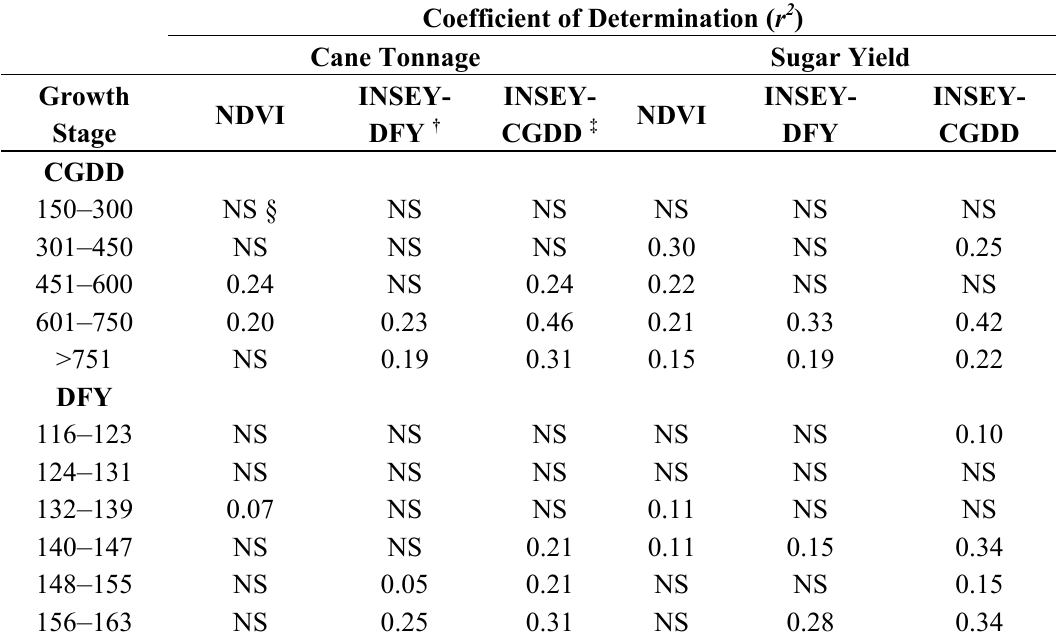
Table 6. Exponential relationship between spectral reflectance measurements and sugarcane crop yield component as a function of time in St. Gabriel and Jeanerette, Louisiana from 2008 through 2011, using cumulative growing degree days (CGDD) and day from the beginning of the year (DFY) when growing degree days >